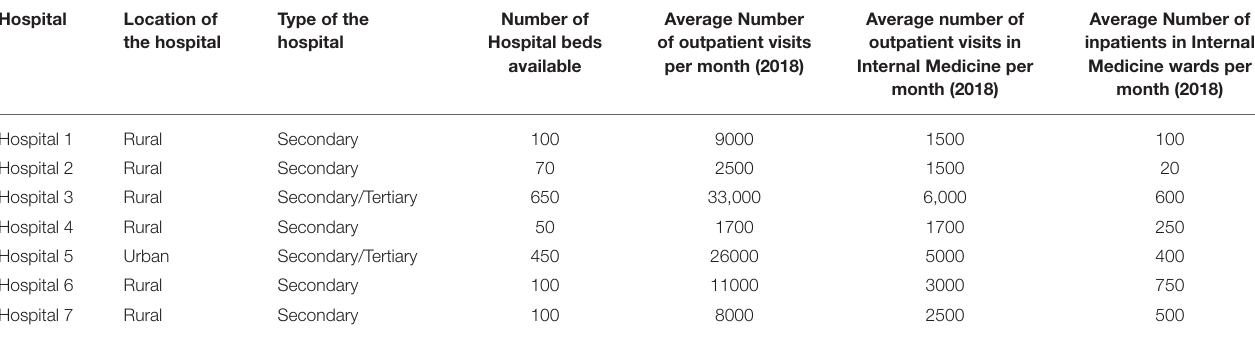
TABLE 1 | Basic Profile of the hospitals.